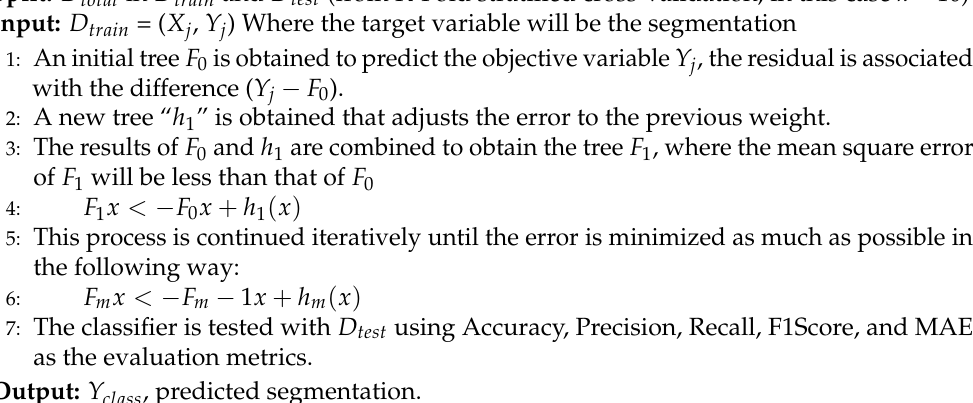
Algorithm 1 Classifier